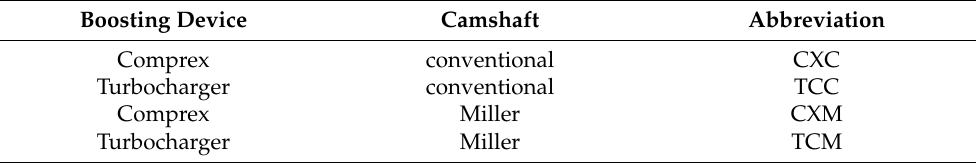
Table 3. Combination of different boosting devices and camshafts and their